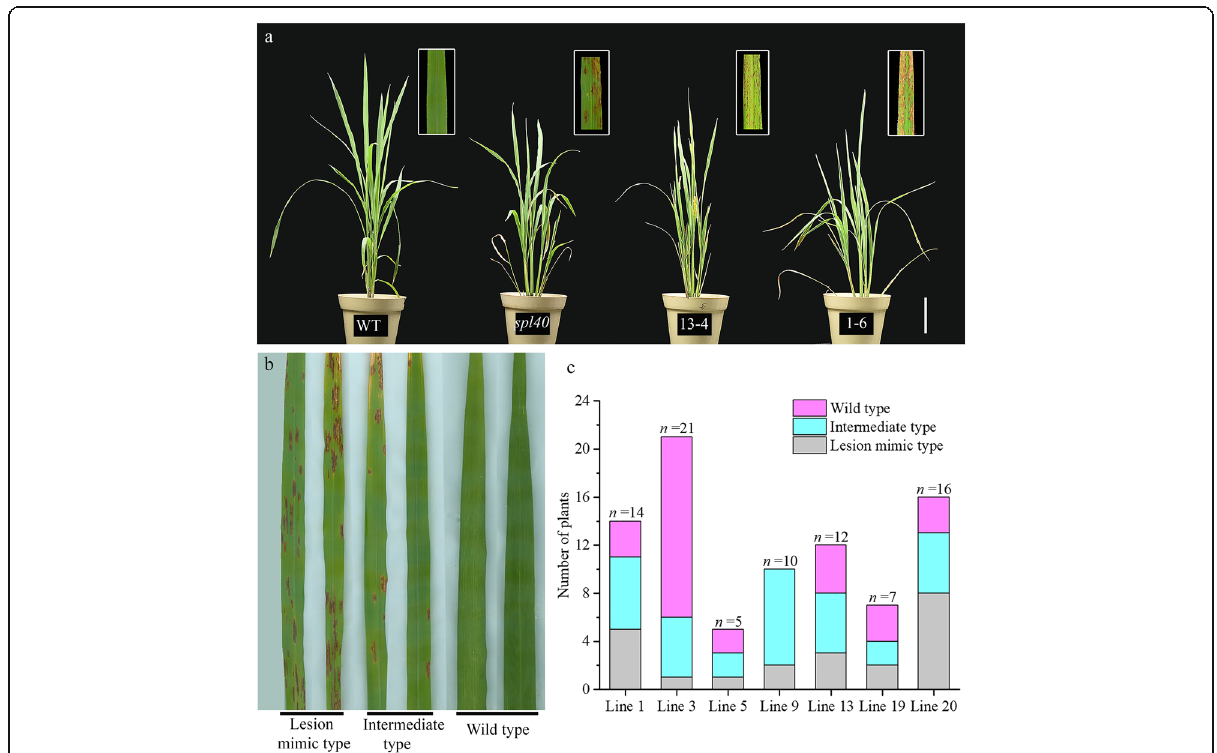
Fig. 7 T 1 transgenic complementation plants. a Phenotype of WT, spl40 and T 1 complementation plants (13 – 4 and 1 – 6). b T 1 leaves representing three phenotypic categories viz., lesion mimic type, intermediate type and wild type. c Distribution of T 1 plants in three phentoypic